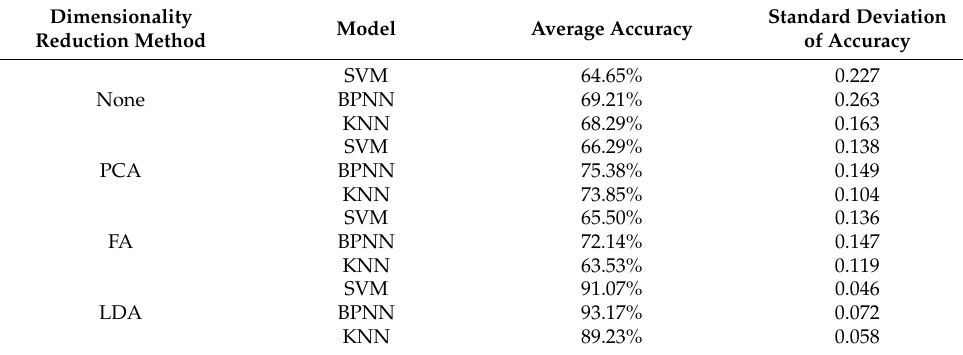
Figure 4. Comparison of different data dimensionality reduction methods: ( a ) PCA dimensionality reduction analysis; ( b ) FA dimensionality reduction analysis; ( c ) LDA dimensionality reduction analysis. Table 4. Average accuracy of KNN, BPNN, and SVM pattern recognition models after different dimensionality reduction methods; the LDA dimensionality reduction method is the best among the three dimensionality reduction methods.